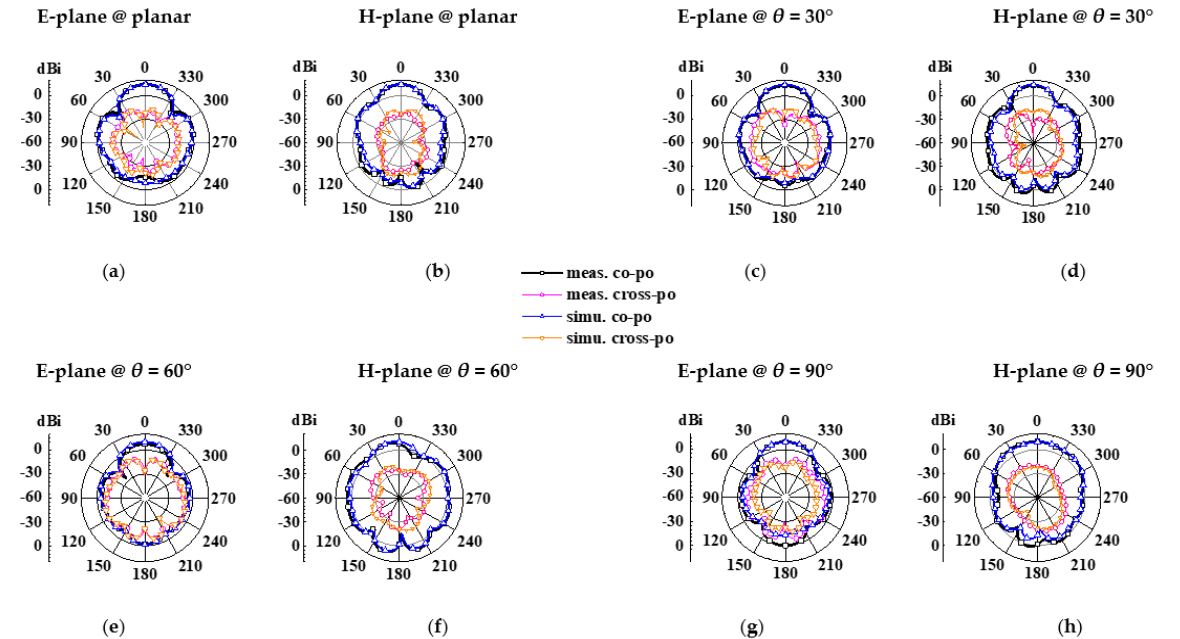
Figure 17. Simulated and measured results for gain radiation patterns and cross-polarization radiation patterns of the proposed antenna array in flat state and under various bending states at 12.5 GHz( a – h ) E-plane and H-plane with various states. Table 3. Performance characteristics of the proposed antenna array.